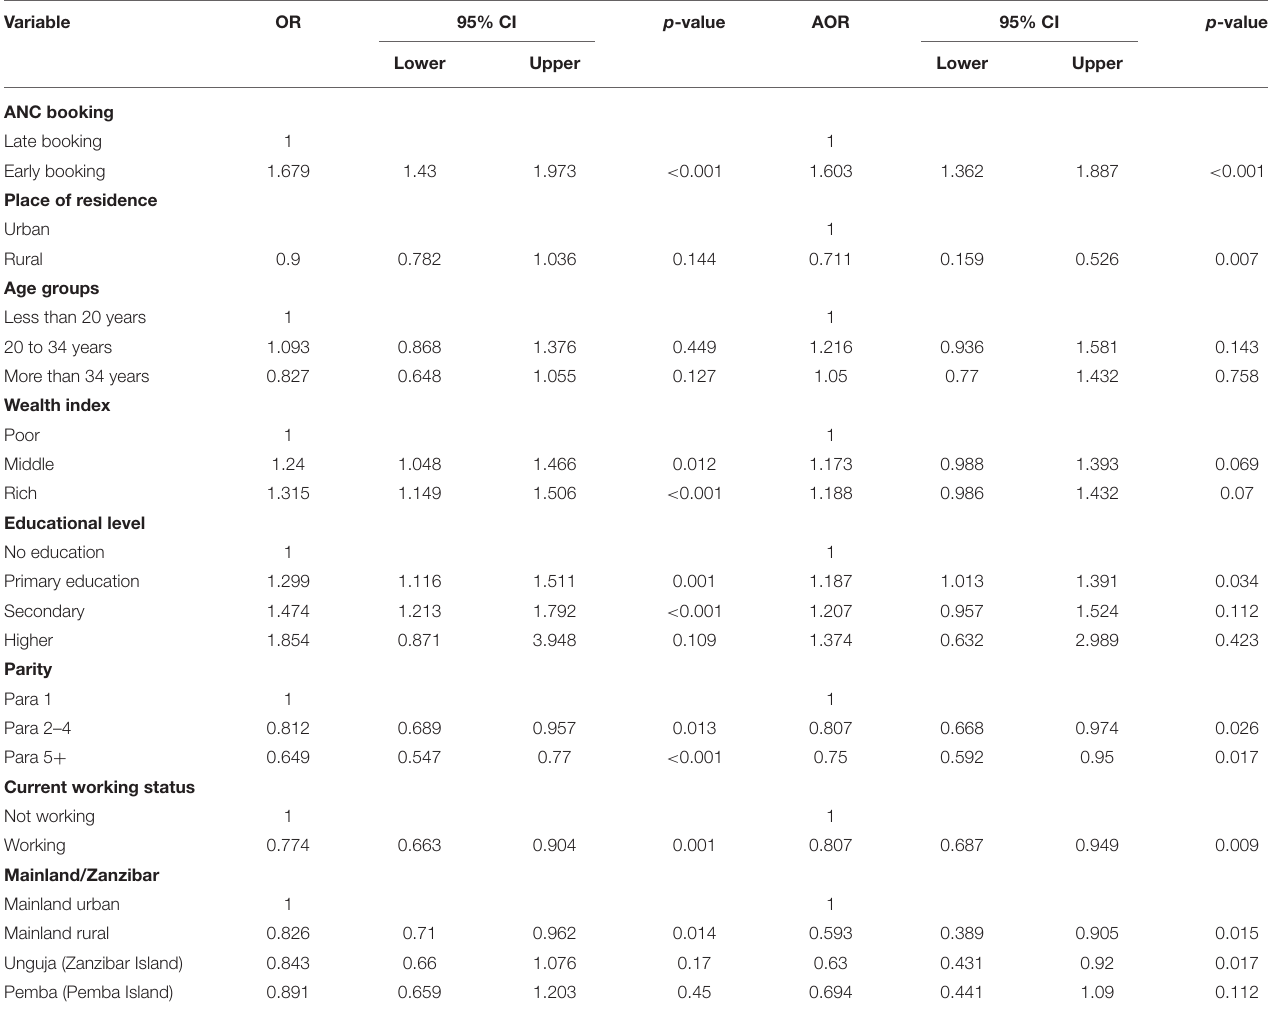
TABLE 3 | Predictors of uptake of iron